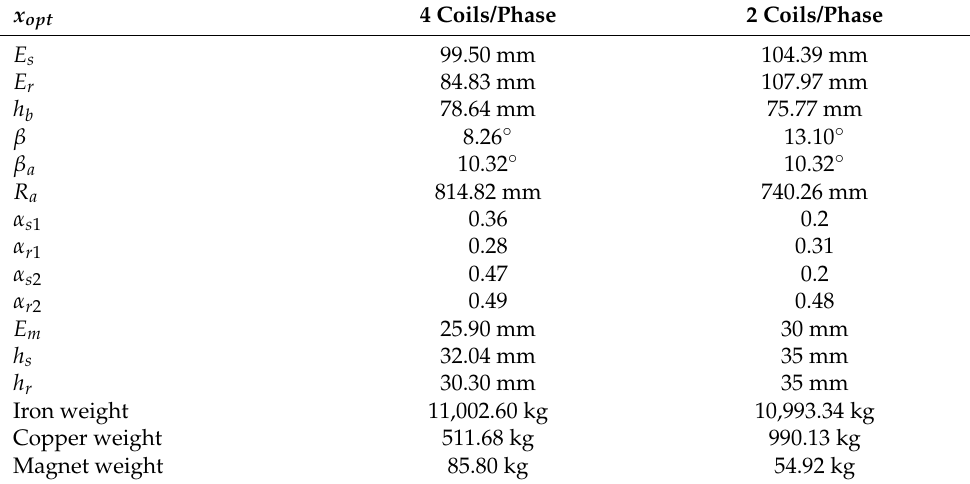
Table 4. Optimal search variables values.